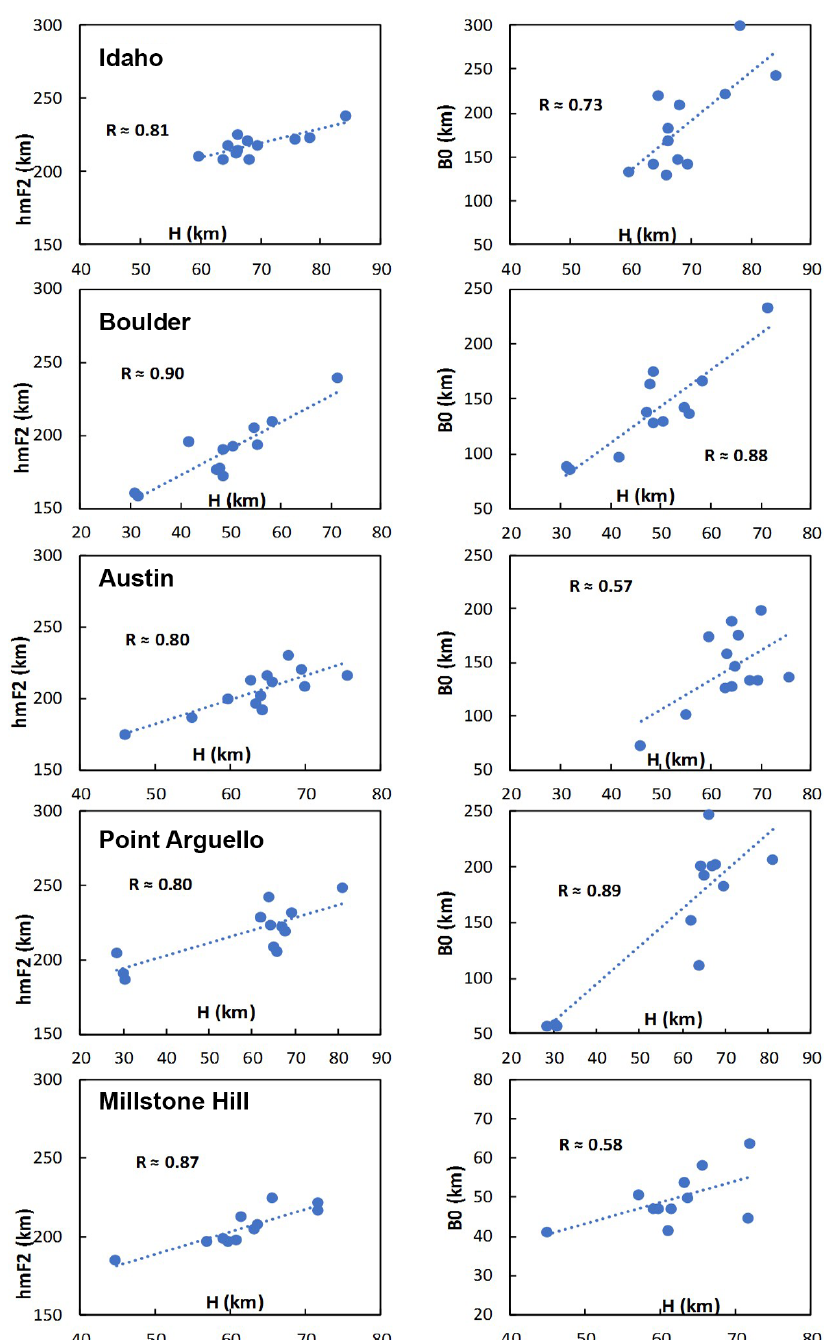
Figure 5. Linear relationship of H versus hmF2 and H versus B0 during the progression phase of the eclipse of 21 August 2017.